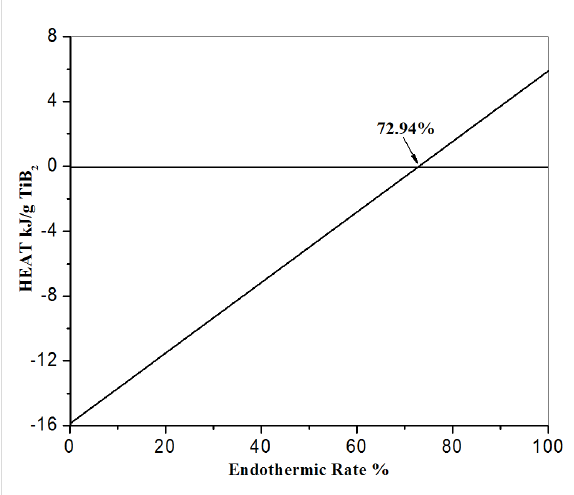
Figure 7: Detailed relationship between the endothermic rate and the total heat